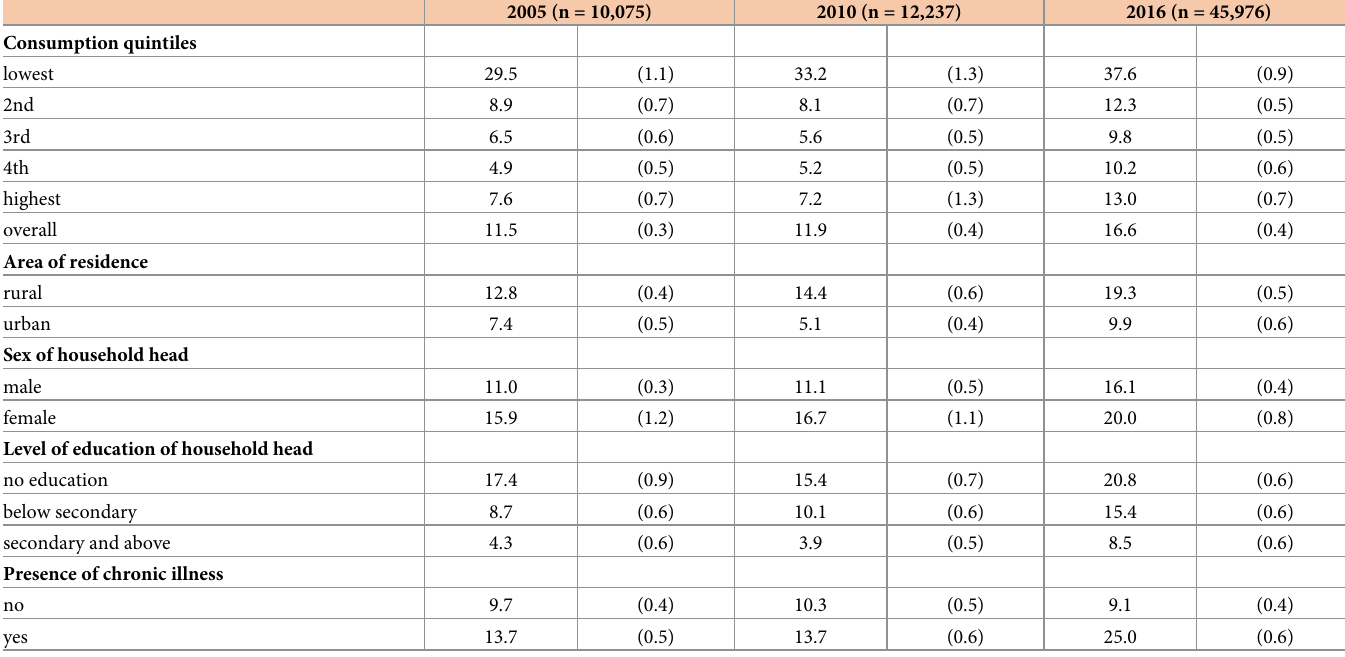
Table 3. The levels and distributions of the incidence of catastrophic health expenditure (%) by year; normative food, housing, and utilities method (40%